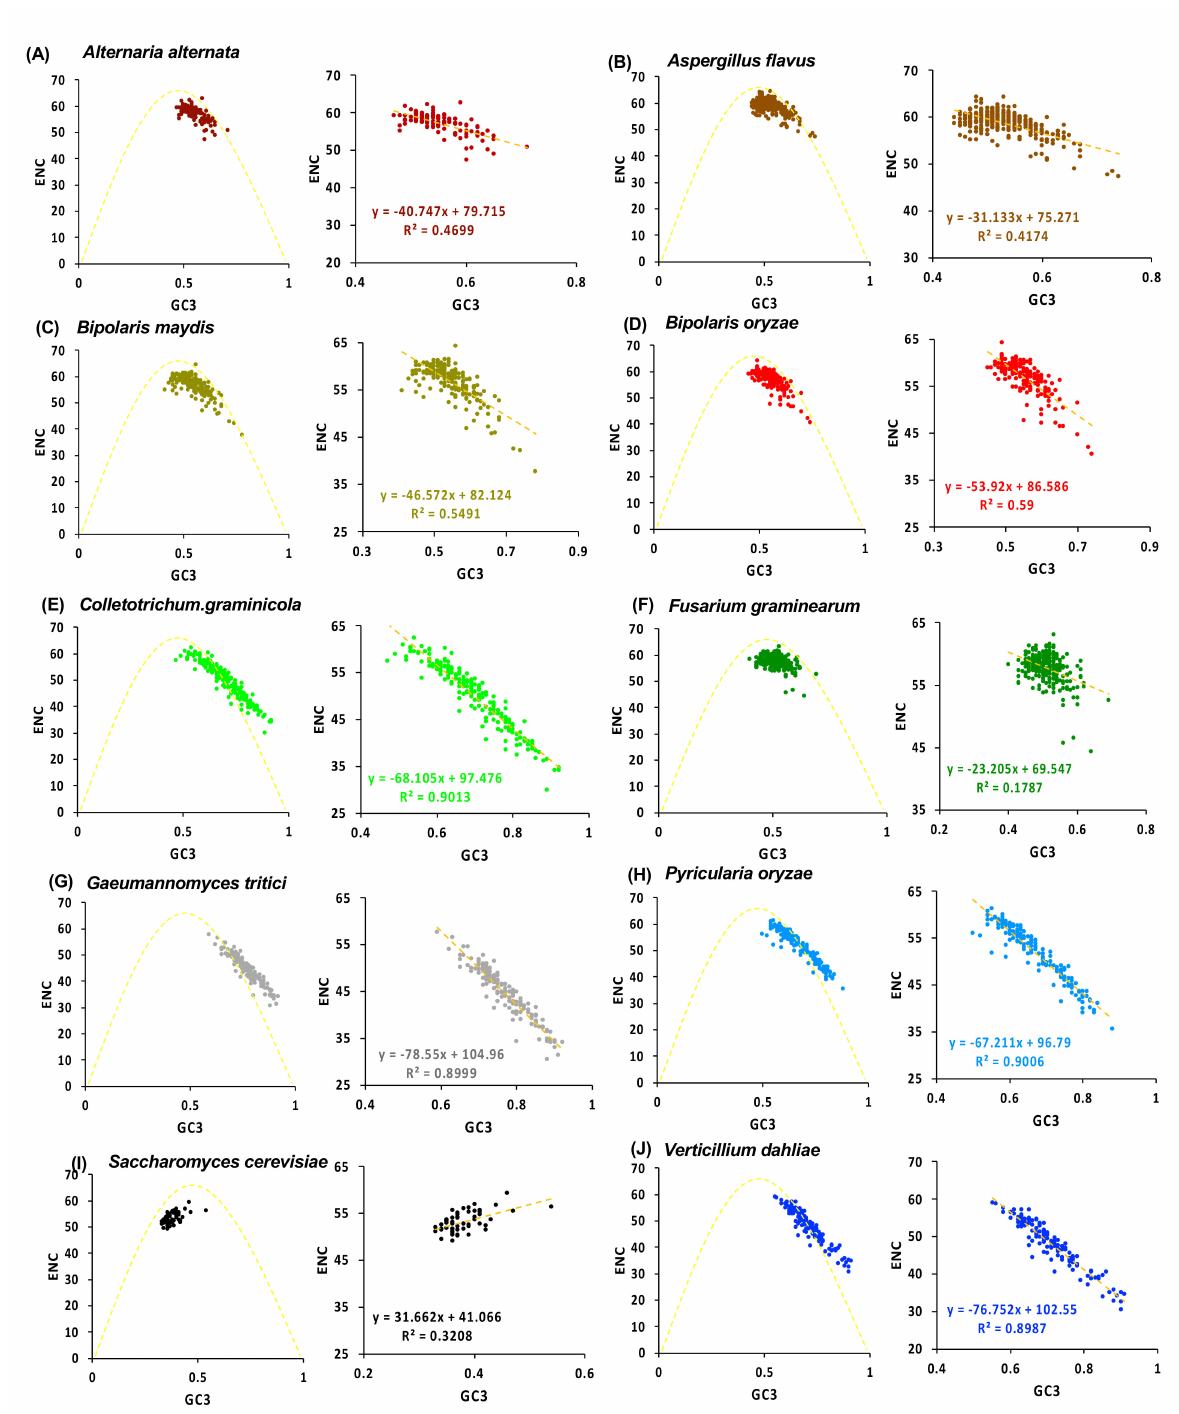
Figure 3. The effective number of codons (ENC)-plot showing a relationship between ENC and GC3s in coding sequences of zinc binuclear cluster family in the target fungal